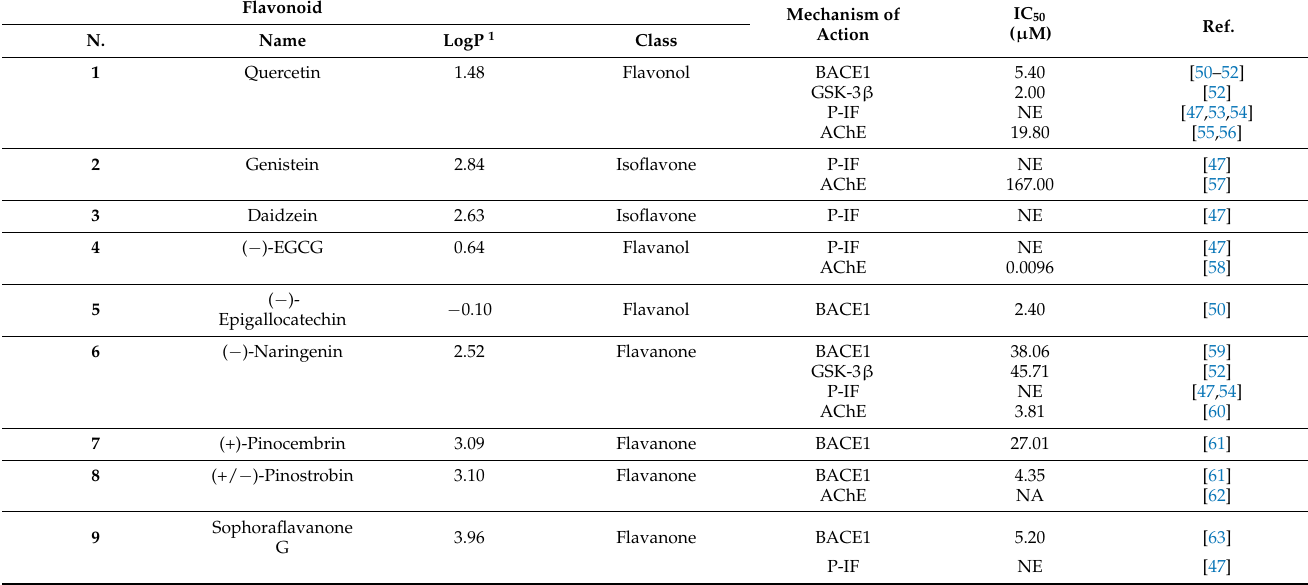
Figure 4. Activities of flavonoids on mechanisms associated with Alzheimer’s disease. Table 2. Flavonoids from natural sources with neurological activities and their mode of action.